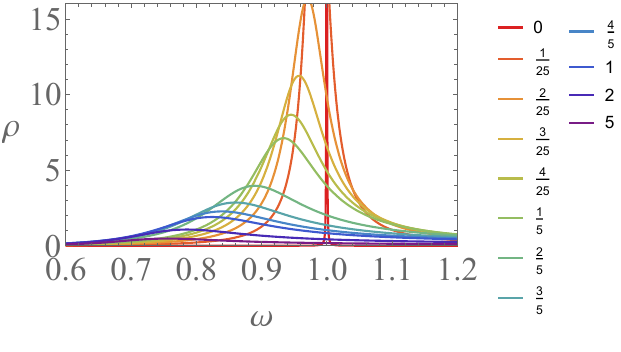
Figure 7 . The spectral function at (cid:21) = (cid:0) 1 for several values of g . The legend shows the value of the dimensionless coupling g